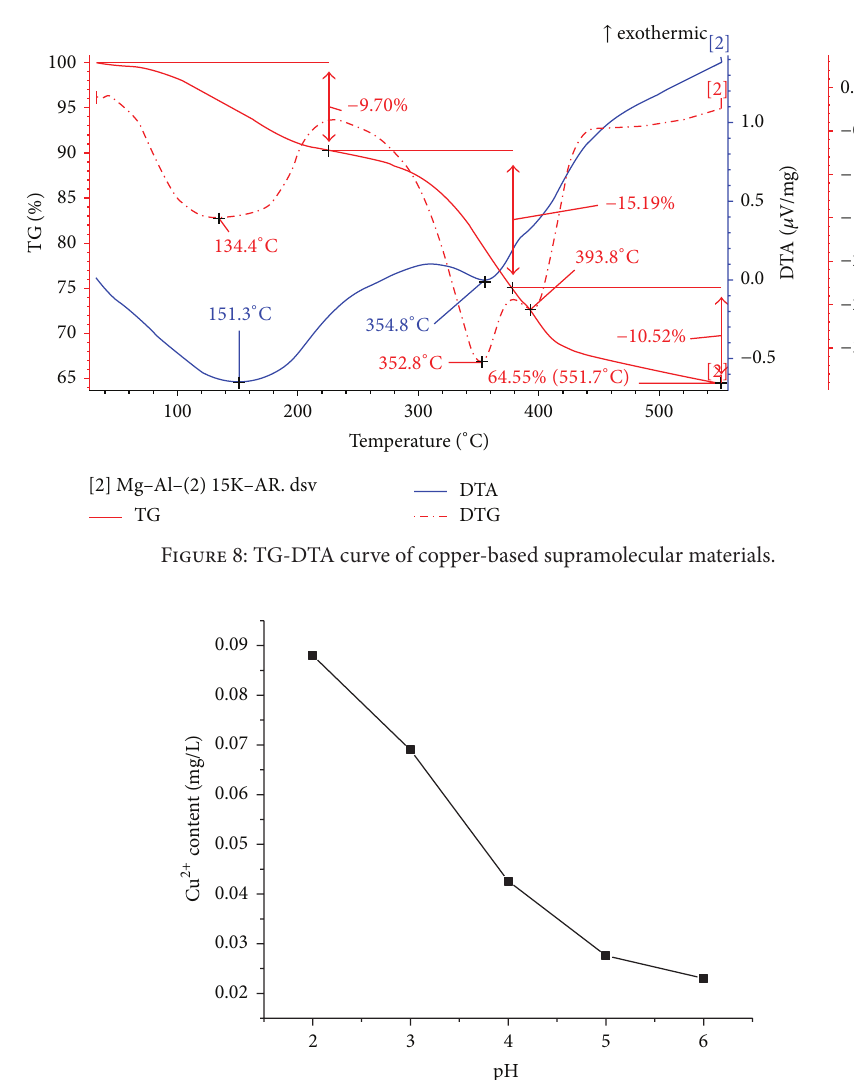
Figure 7: Maximum treatment of electroplating wastewater containing copper.